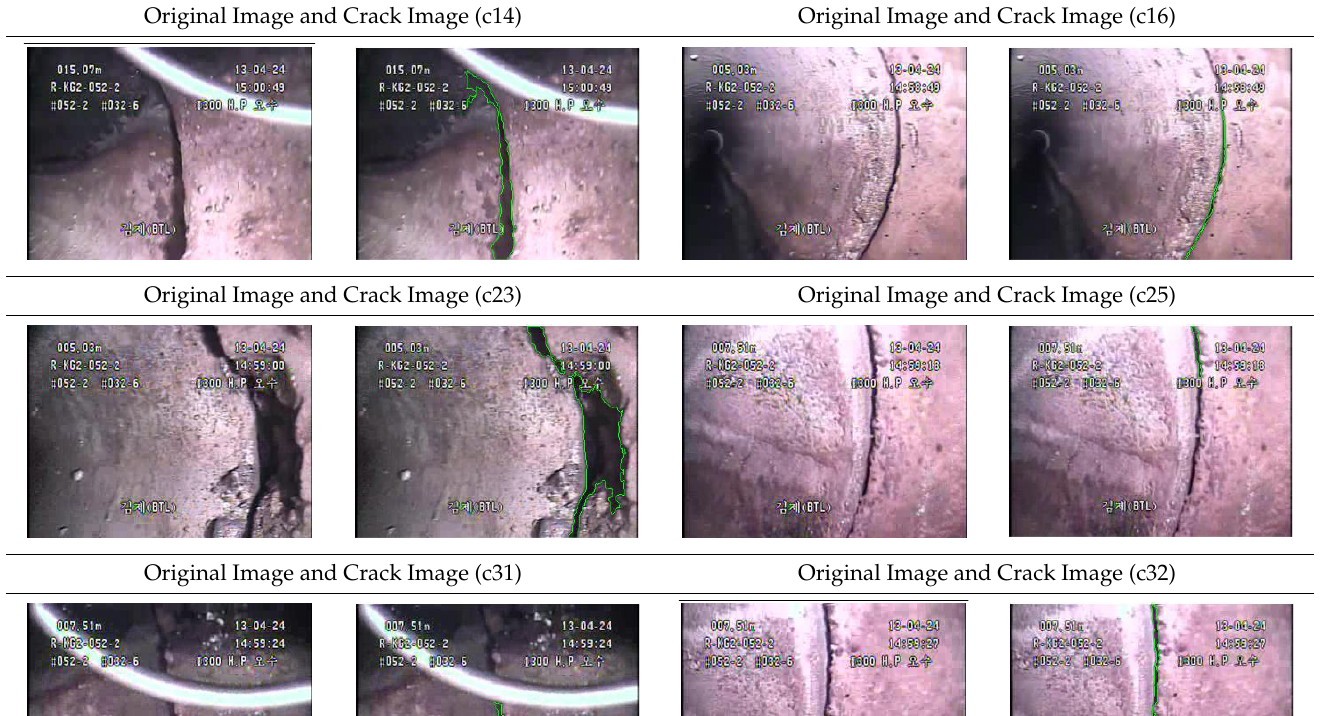
Table 13. Good results of crack images (all results).